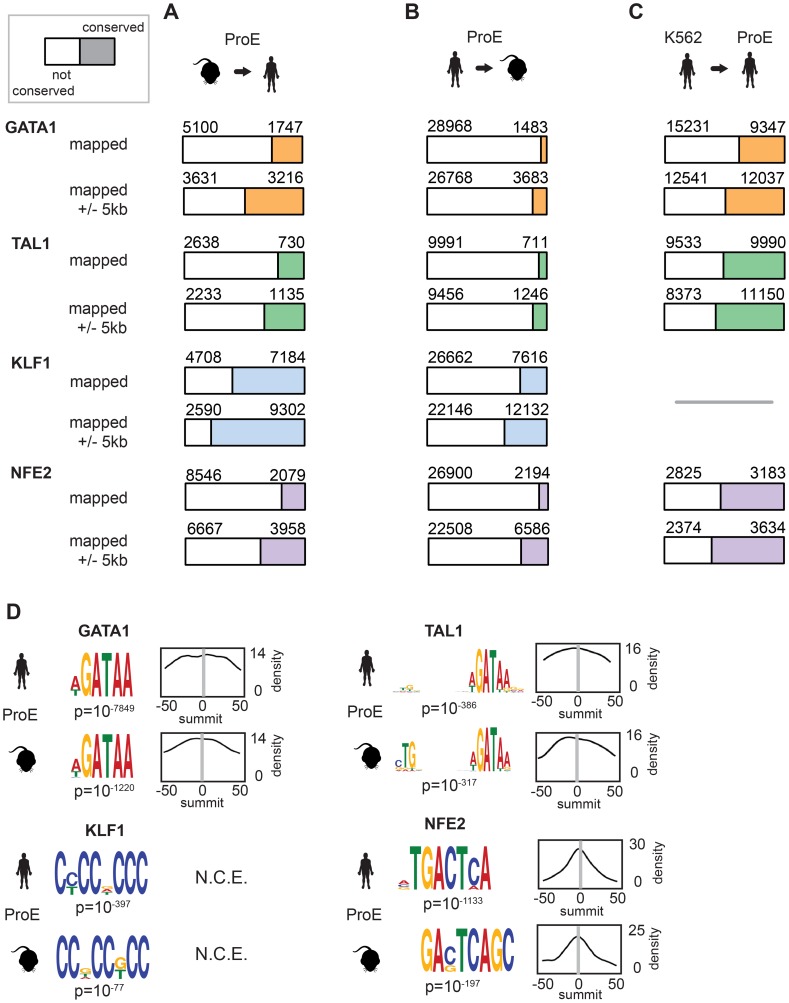
Divergence of transcription factor occupancy sites between human and mouse.A) For each TF (GATA1, TAL1, KLF1, and NFE2), a narrow occupancy site (summit +/- 50 bp) was mapped from mouse ProEs (mm10) to hg19 coordinates using the UCSC liftOver tool and intersected with corresponding peaks in human ProEs. To investigate “compensatory” new occupancy sites in hg19, narrow peaks that were mapped were expanded 5000 bps in each direction and the overlap was recomputed. The denominator (blue, orange, green, or purple plus white) represented the total number of mapped peaks from mouse ProEs to hg19, and the numerator (blue, orange, green, or purple) represented the total number of these mapped peaks that overlap with peaks in human ProEs, referred to as “conserved” occupancy in the main text. B) Similar to A), except that peaks in human ProEs (hg19) were mapped to peaks in mouse ProEs (mm10). Please note that the total number of peaks mapped from mouse to human is smaller than the number mapped from human to mouse. C) Similar to B), except that peaks in the K562 erythroid cell line were directly intersected with peaks in human ProEs. KLF1 data was not available for K562 cells so no overlap was computed. D) For each peak in human and mouse ProEs, MeME-Chip was used to recover canonical motifs for each TF (GATA1, TAL1, KLF1, and NFE2) in a small window (+/- 50 bps) around the summit of each peak. The probability density for each motif is shown across the region (for example, a density of 14 is a probability of 0.14 on a 0 to 1 scale). Abbreviations used: ProEs, pro-erythroblasts; N.C.E, no central enrichment.